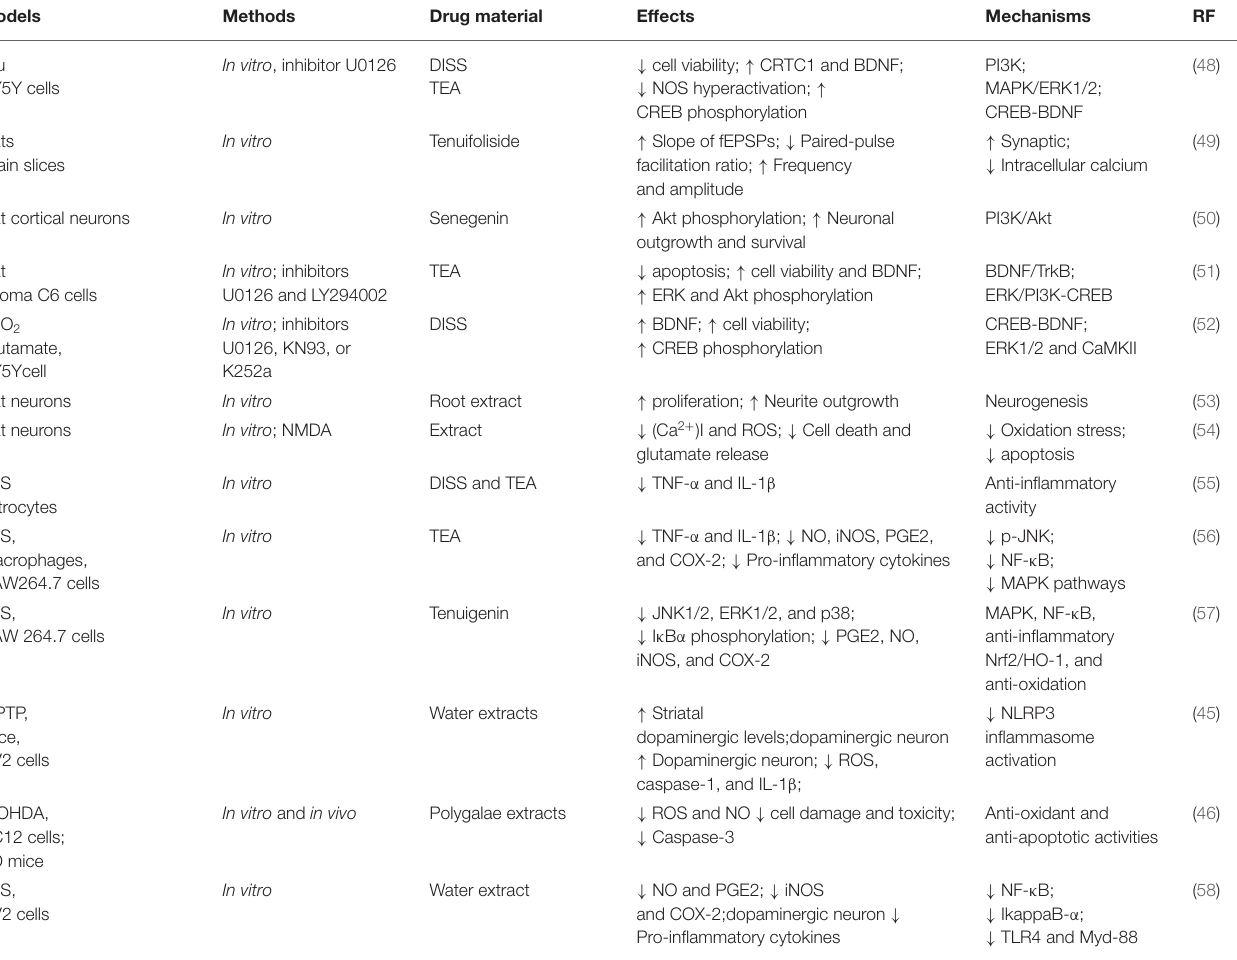
TABLE 3 | Neuroprotective mechanisms of Radix Polygalae against oxidation stress, inflammatory, and apoptosis in the nervous system.